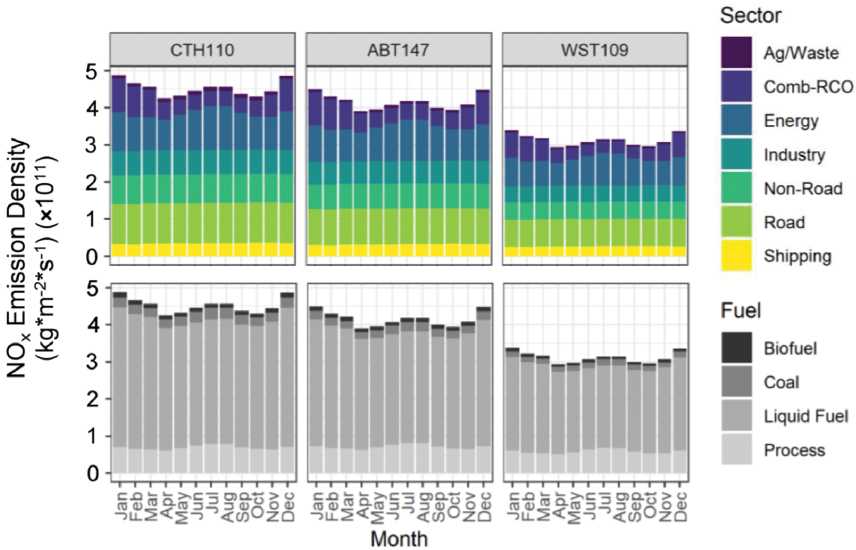
Figure 5. Estimated NO x emission density by sector and fuel type for source regions contributing to the considered CASTNET sites, including Connecticut Hill, NY (CTH110); Abington, CT (ABT147); and Woodstock, NH